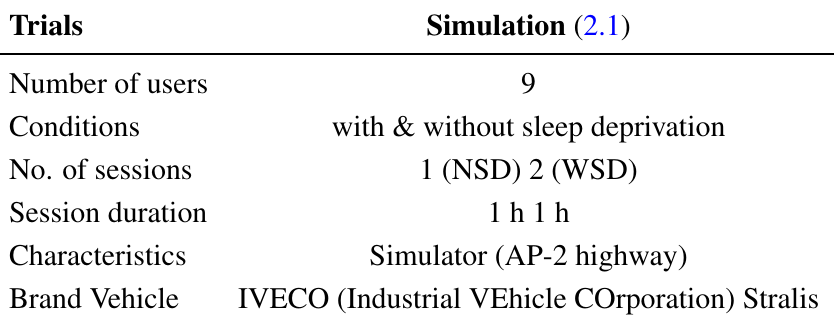
Table 1. Distribution and main features of driving trials. NSD, no sleep deprivation; WSD, with sleep deprivation.